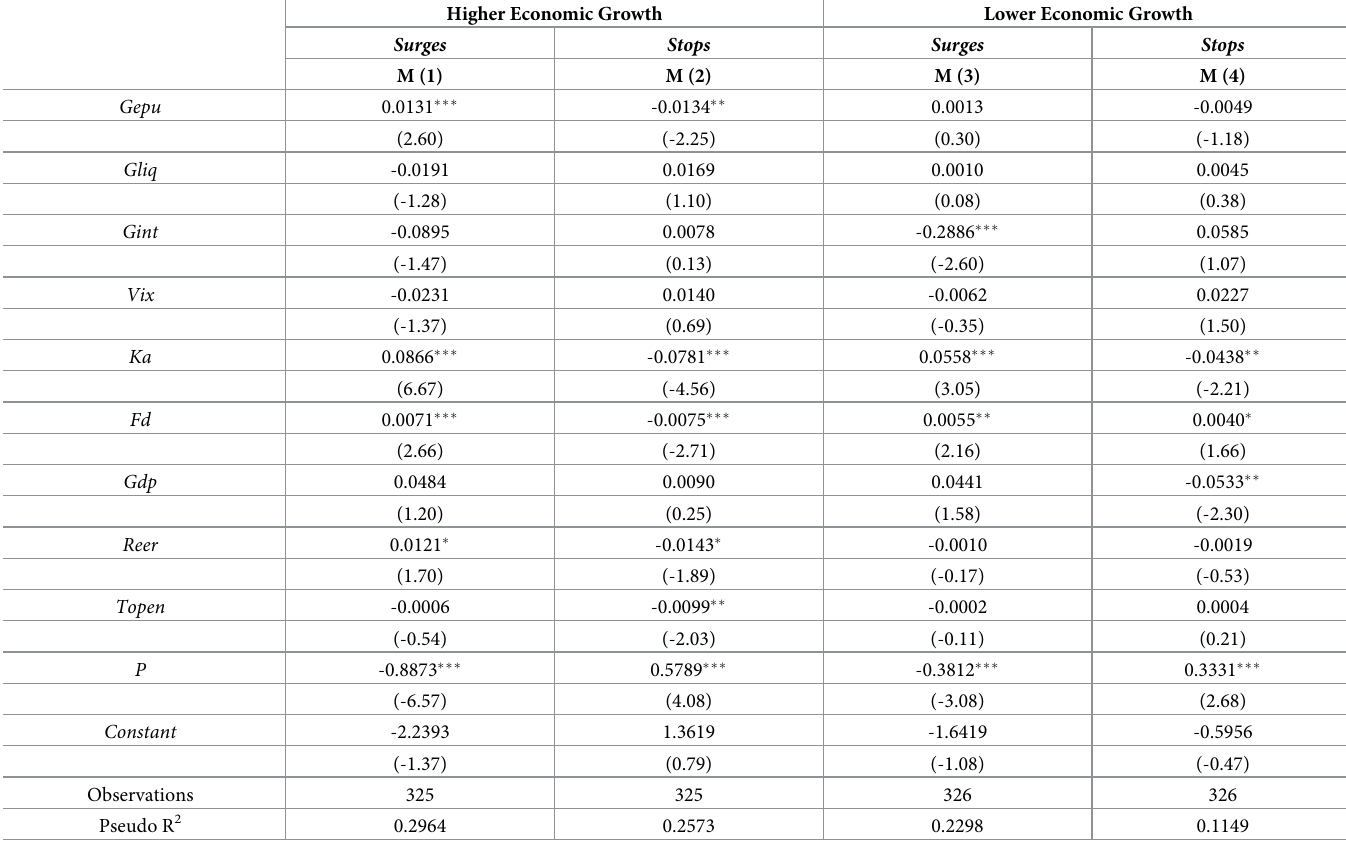
Table 5. Heterogeneity test results of economic